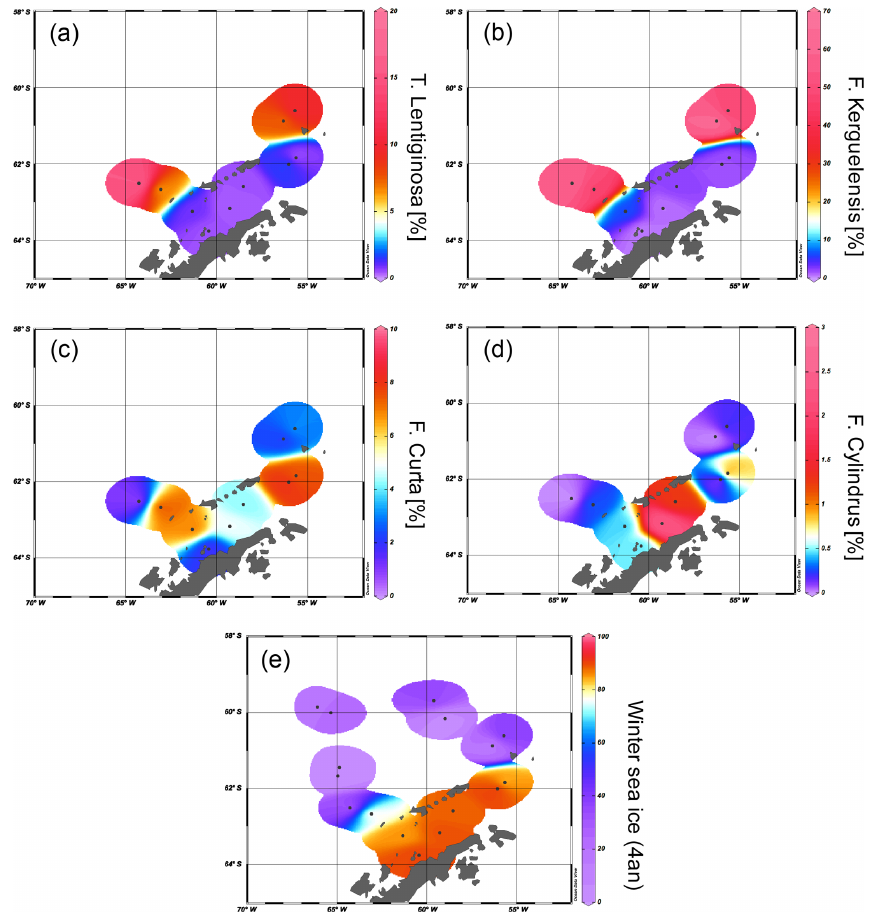
Figure 5. Distribution of the diatoms (a) T. lentiginosa , (b) F. kerguelensis , (c) F. curta and (d) F. cylindrus in the study area (percentage per sample). The winter sea ice concentrations from the application of transfer function of Esper and Gersonde (2014a) are shown in (e)